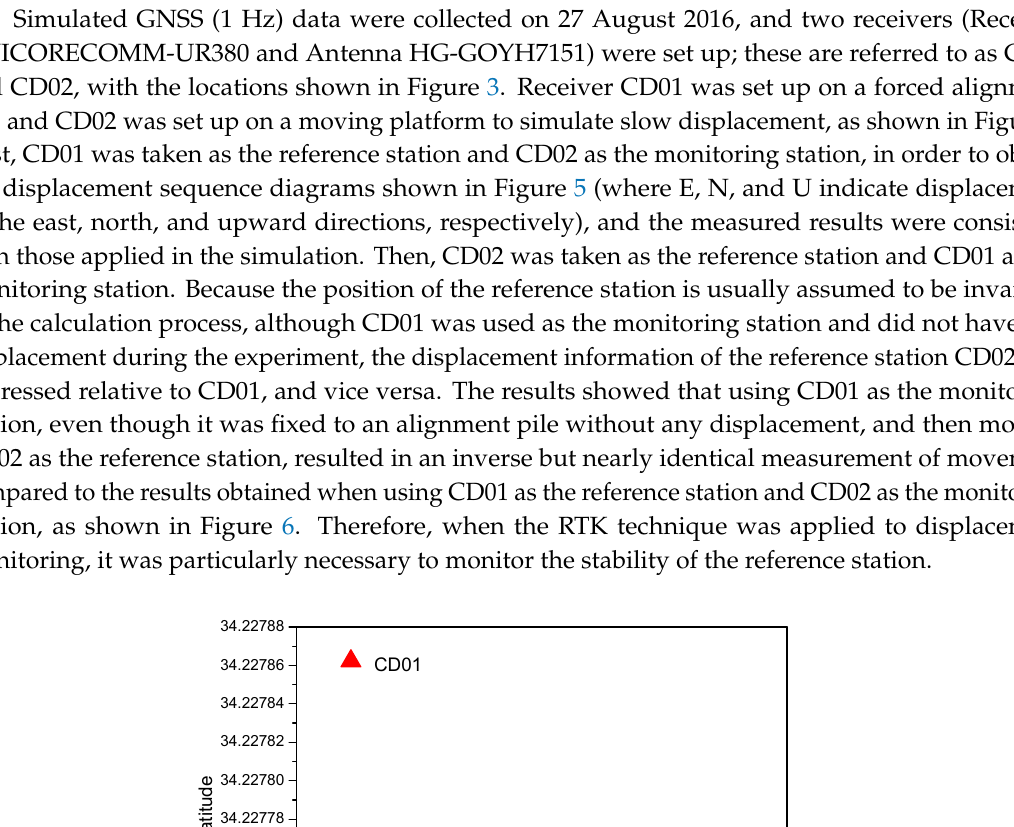
Figure 4. CD02 antenna installed on the moving platform. 0